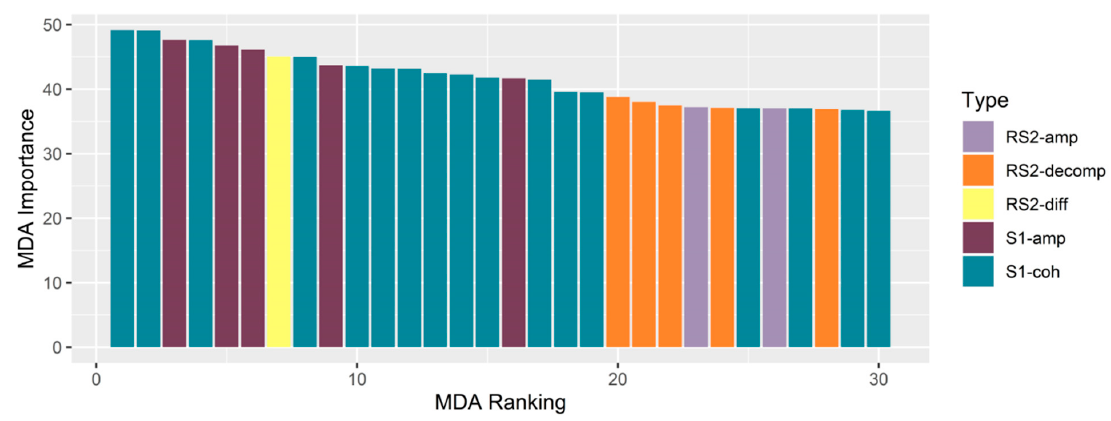
Figure 6. Variable importance and type for top 30 variables, based on mean decrease in accuracy (MDA) ranking using all RS2 and S1 channels.